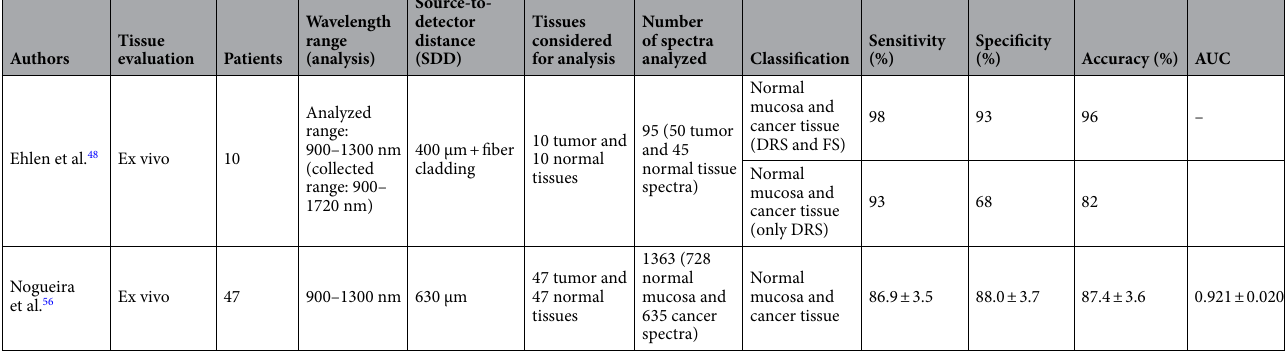
Table 5. Comparison of clinical data, instrument specifications and classification performance metrics across optical spectroscopy studies. The dataset of this study (represented by the Nogueira et al. 56 in the table) was evaluated in the wavelength ranges of previous studies and for comparison of classification